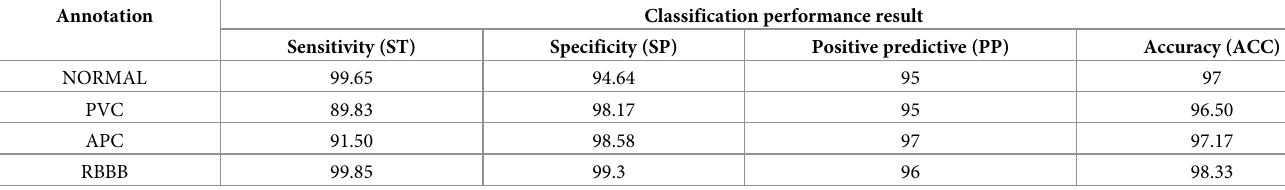
Table 1. Collective result performance analysis and classification result using FFT and improved AlexNet.